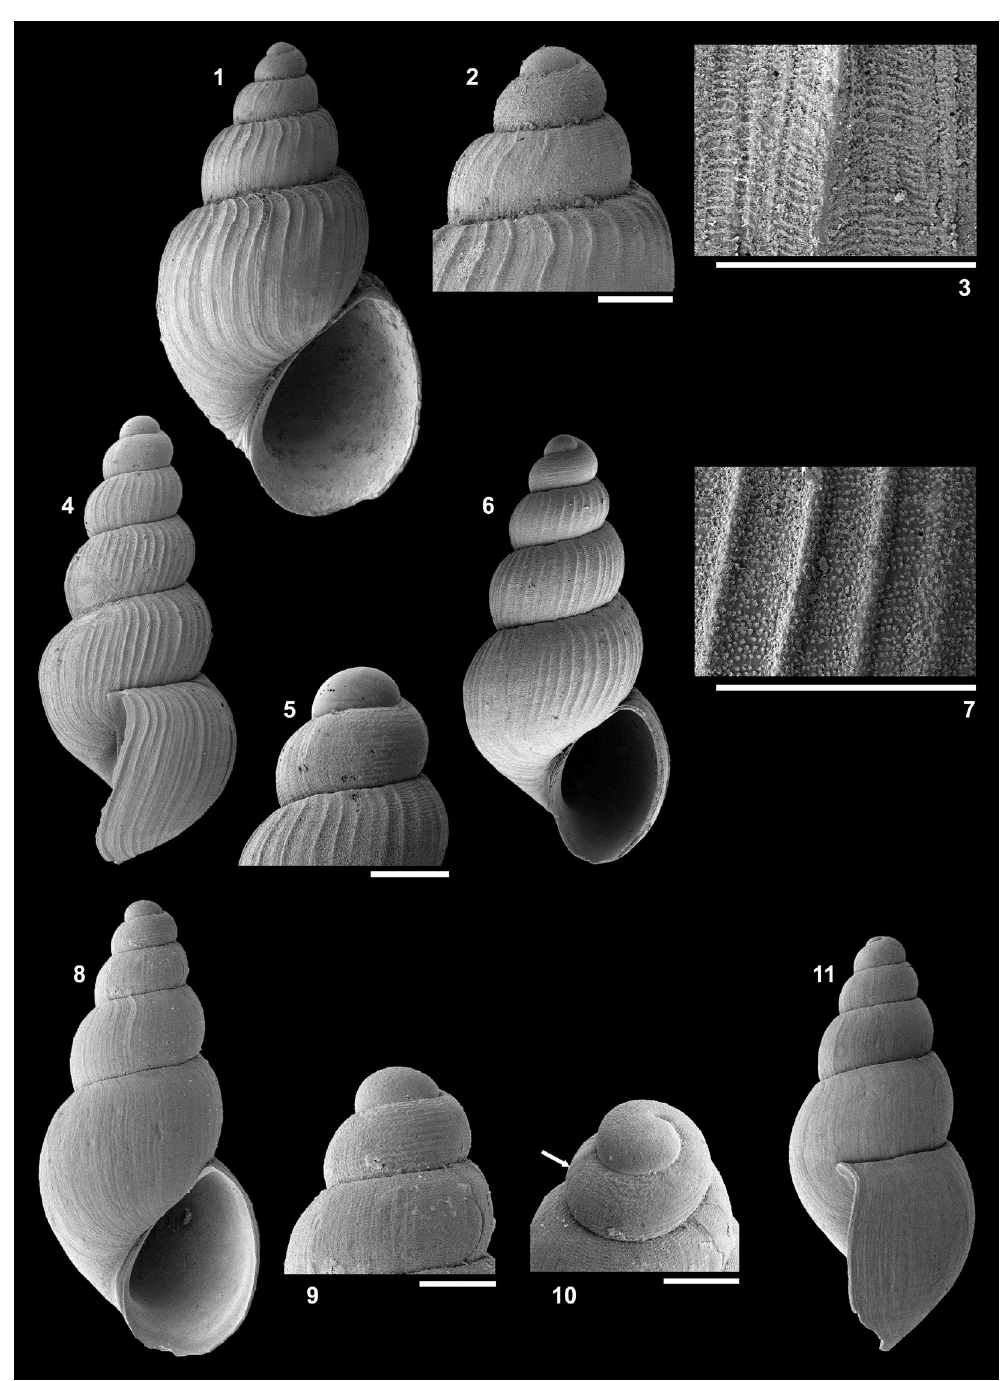
Figs 1–11. Talassia Warén & Bouchet, 1988 from the NE Atlantic. 1–3 . Talassia coriacea (Manzoni, 1868), off Funchal, Madeira, depth 70 m (SaM74968). 1 . Ventral view, H = 2.7, W = 1.5 mm, Ha = 1.2 mm. 2 . Protoconch, Wp = 0.37 mm. 3 . Sculpture body whorl. 4–7 . Talassia dagueneti (de Folin, 1873), Porcupine Seabight, Galway Mound, POS316-524 (SaM). 4–5 . Side view, H = 2.5